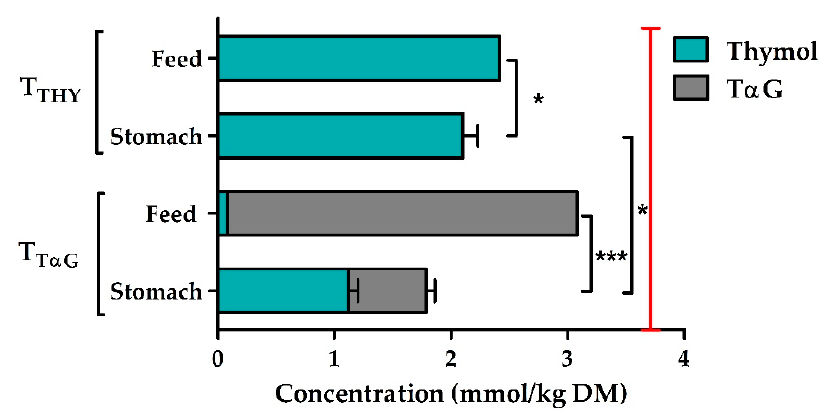
Figure 1. The concentration of thymol and thymol α -D-glucopyranoside (T α G) in the feeds and stomach digesta of piglets fed an intended dose of 3.7 mmol / kg DM (vertical red line) of thymol (T THY ) or T α G (T T α G ).